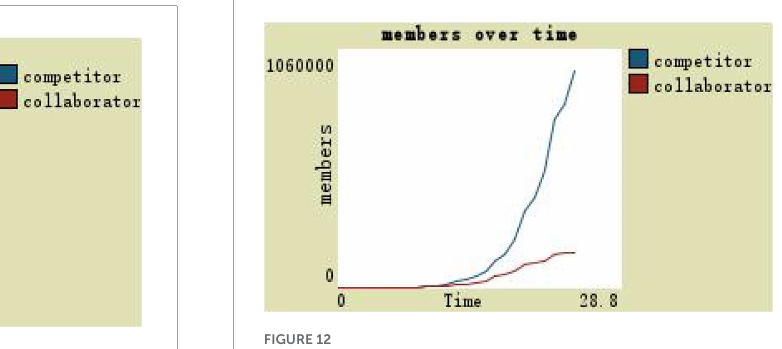
FIGURE9 Team members change with high level of trust.